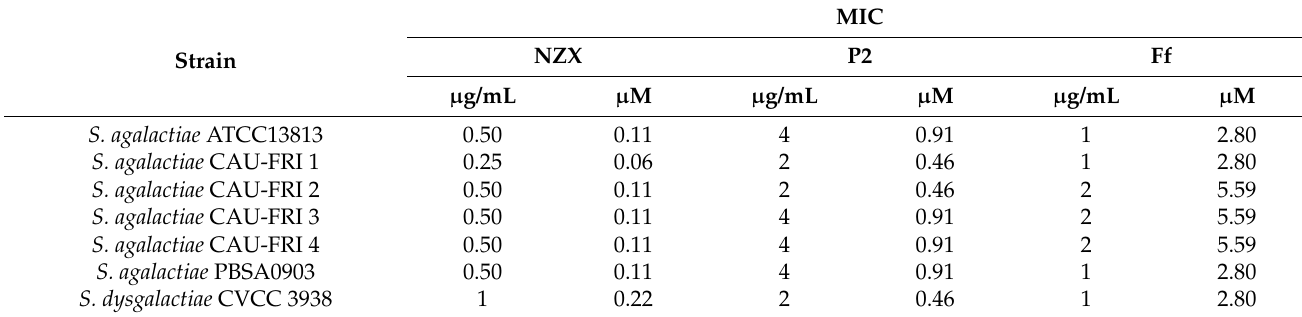
Table 1. The MIC of peptides and Ff.